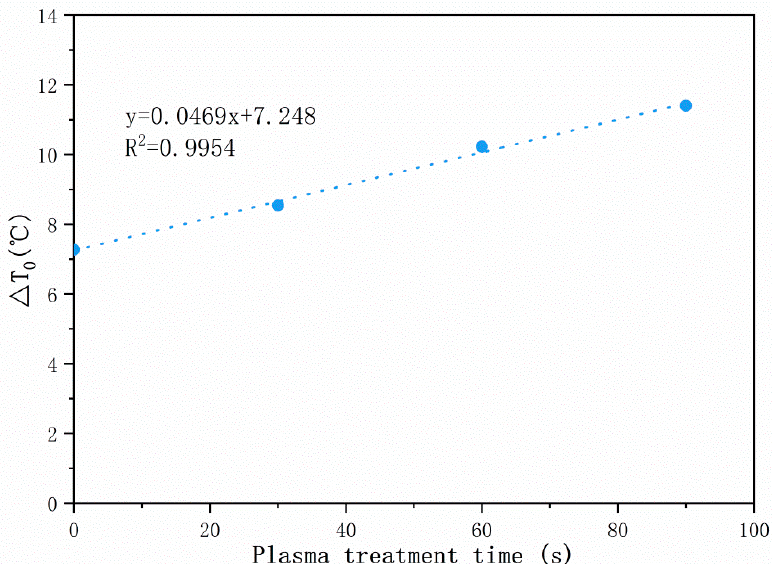
Figure 9. The intrinsic temperature reductions of the passive cooling films as the increase of plasma treatment time, showing a perfect linear -regression fi t.